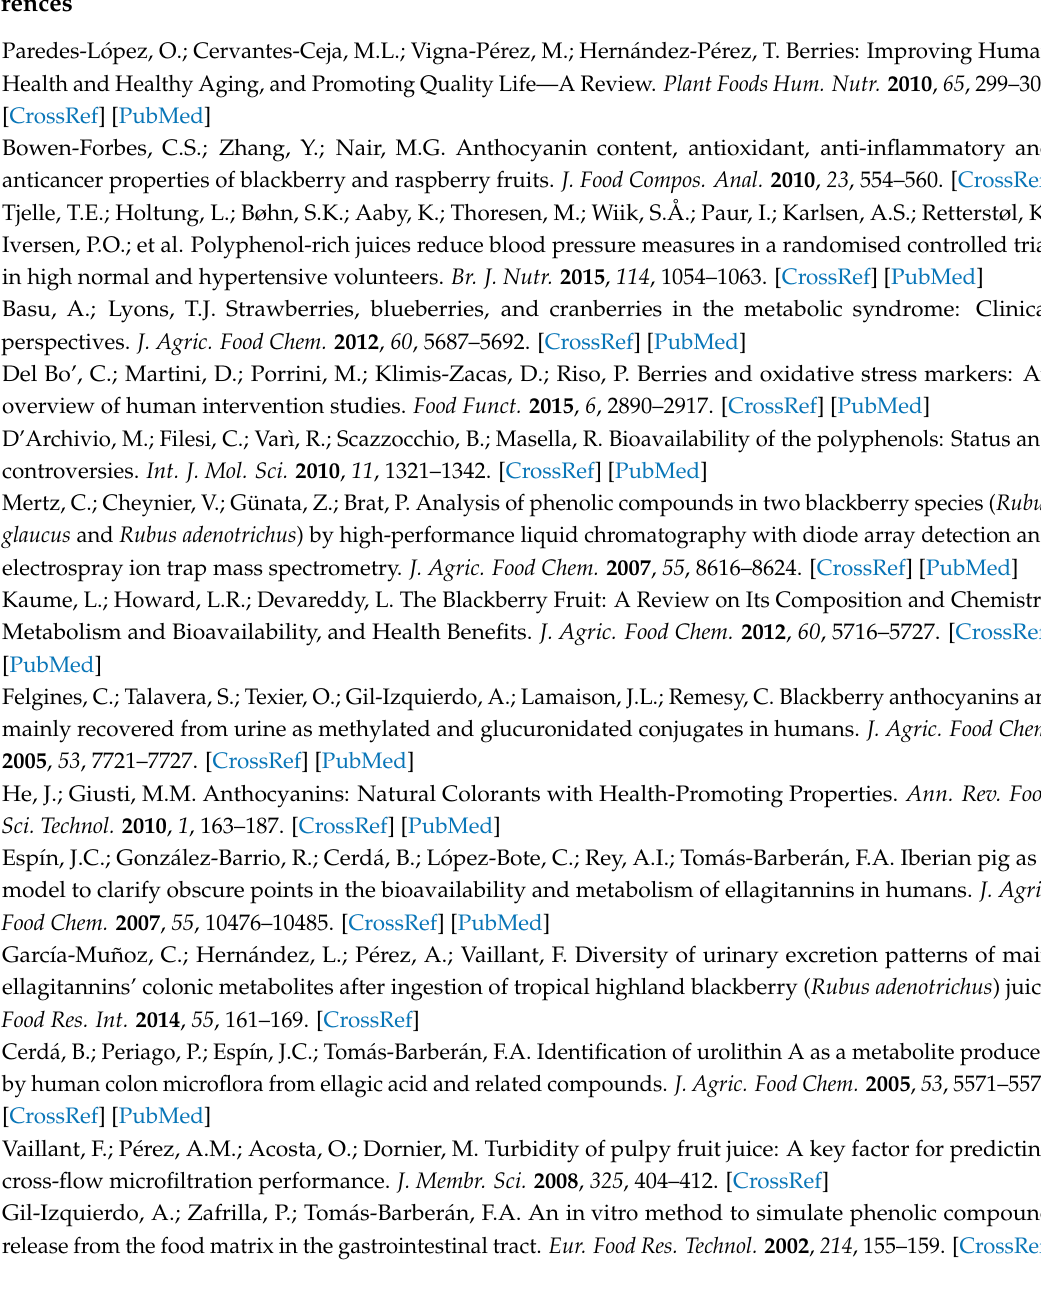
Figure S1: Calibration curve used for the HPLC quantification of anthocyanins and ellagitanins, Figure S2. Inhibitory capacity of the digested blackberry juice polyphenols against lipid peroxidation in liposomes (A), liver homogenates (B) and erythrocytes (C). Each value is the mean ± S.E. (three independent